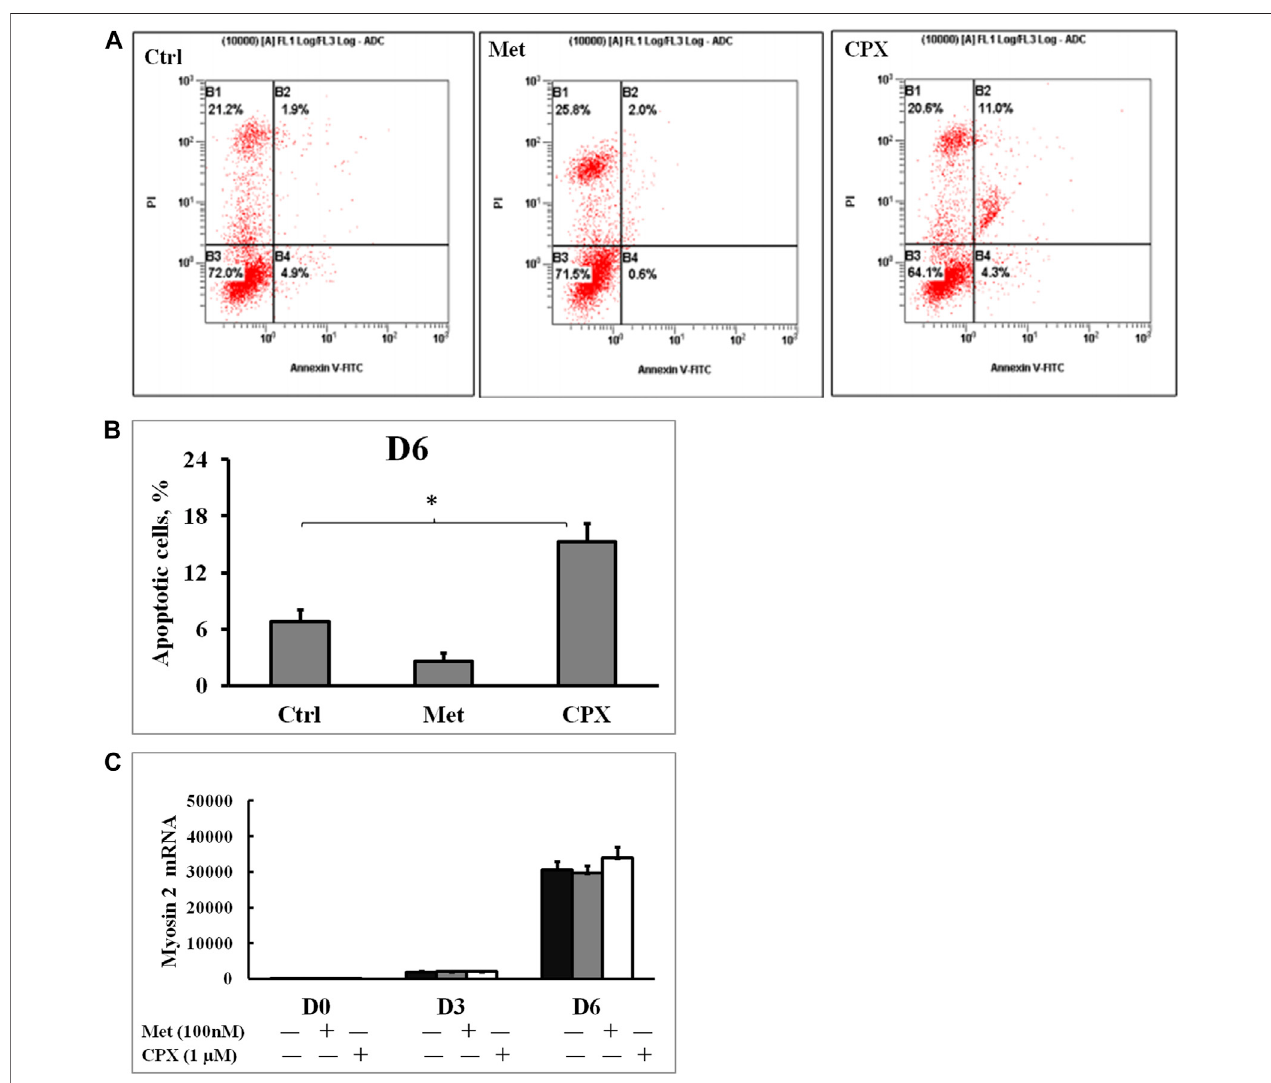
FIGURE2| TheeffectofhistamineH3receptormodulatorsoncellapoptosisandmyogenesis. (A) :Apoptoticcellsweredetected by fl owcytometryusingAnnexin V and propidium iodide staining; percentage of mechanically damaged cells (top left quadrant) , live cells (bottom left) , early apoptotic cells (bottom right) , late apoptoticcells (topright) . (B) :Percentageofapoptoticcellswascalculatedbyaddingtheearlyandthelateapoptoticcellsforeachexperimentalcondition. *p < 0.05vs. control. (C) :TheC2C12myocyteswereincubatedinthepresenceofMet(100nM)orCPX(1 μ M)for12hatD6,andtheeffectofH3receptorinhibitionoractivation on myogenesis was assessed by analyzing the expression of the late myogenesis marker, myosin 2, mRNA by real time RT-PCR. *p < 0.05 vs. control of the same differentiation day (black columns); normalizing D0 ctrl (cid:2) 1. There was no statistical difference when Met or CPX was compared with control group (dark gray